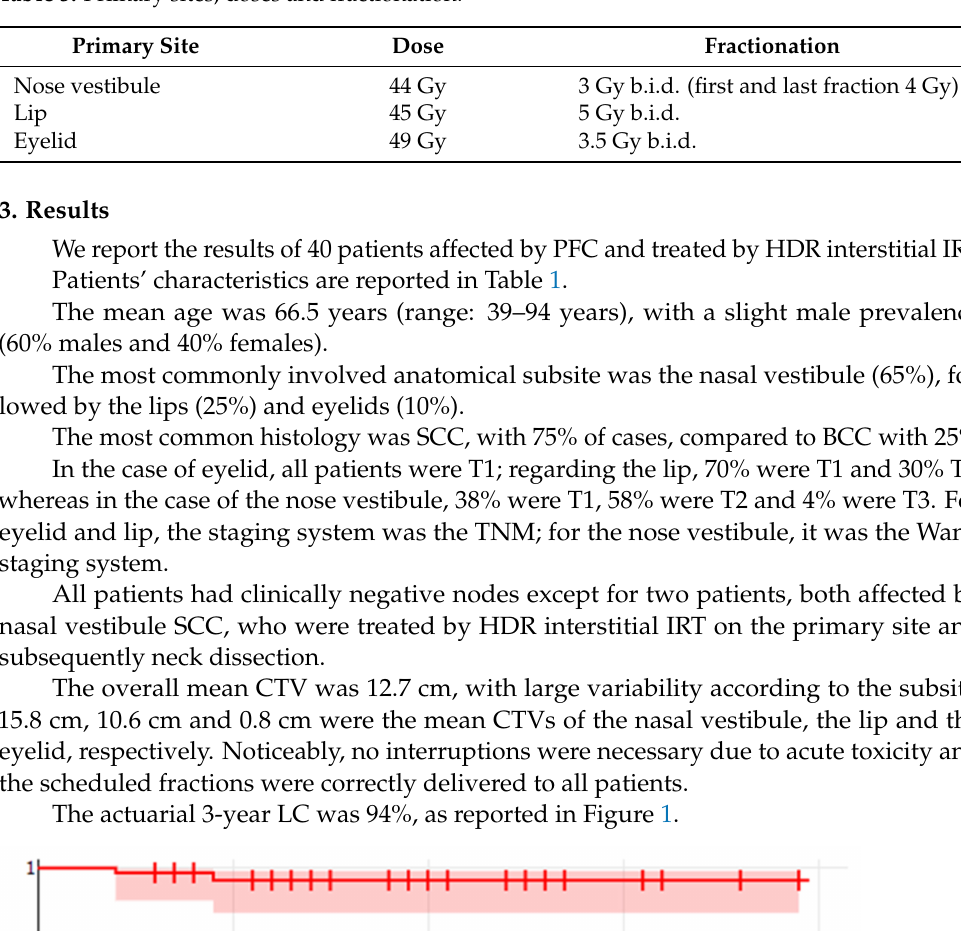
Table 3. Primary sites, doses and fractionation.